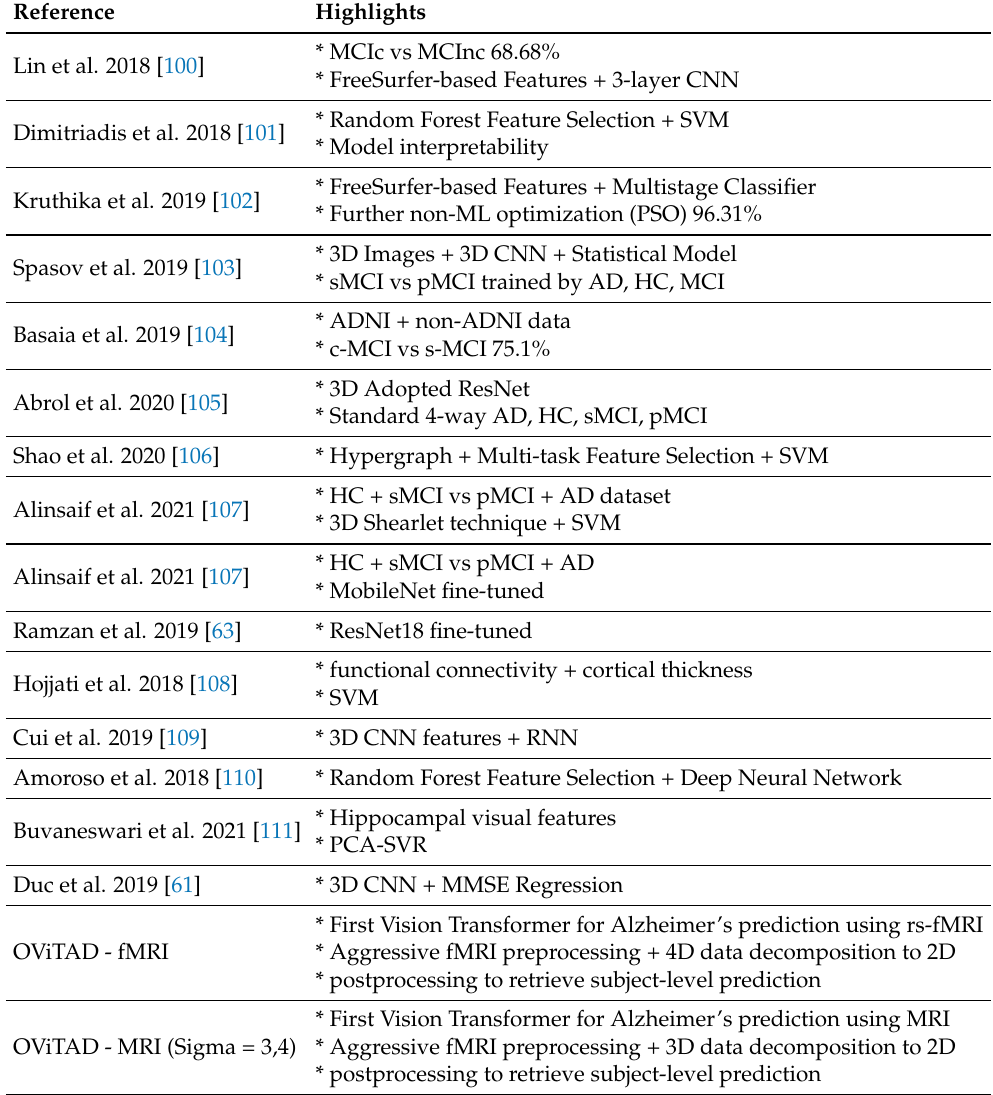
Table A7. The summary of highlights for each